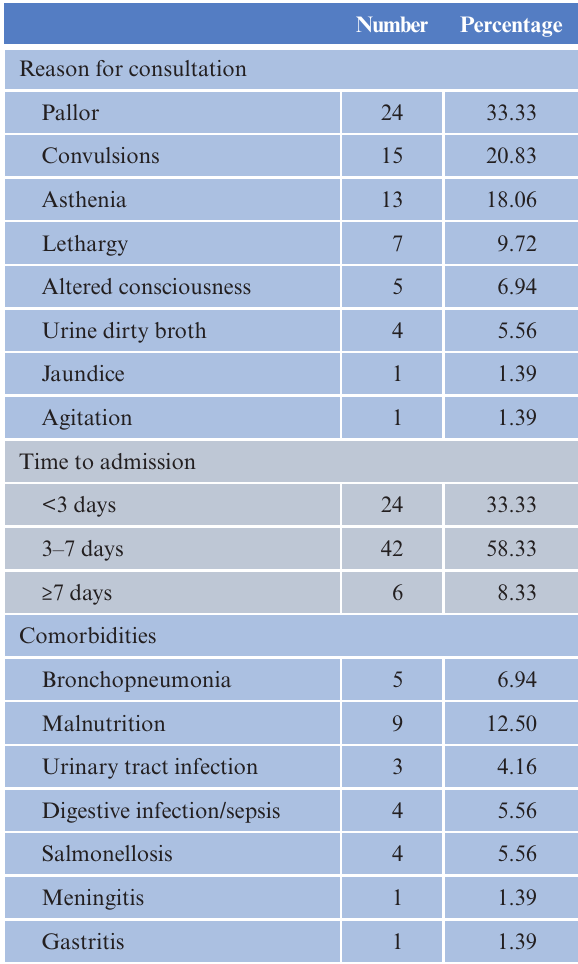
Table 2: Distribution of children with severe malaria and kidney damage according to reason for consultation, admission time, and comorbidities at the Borgou DTH in 2021 (n =